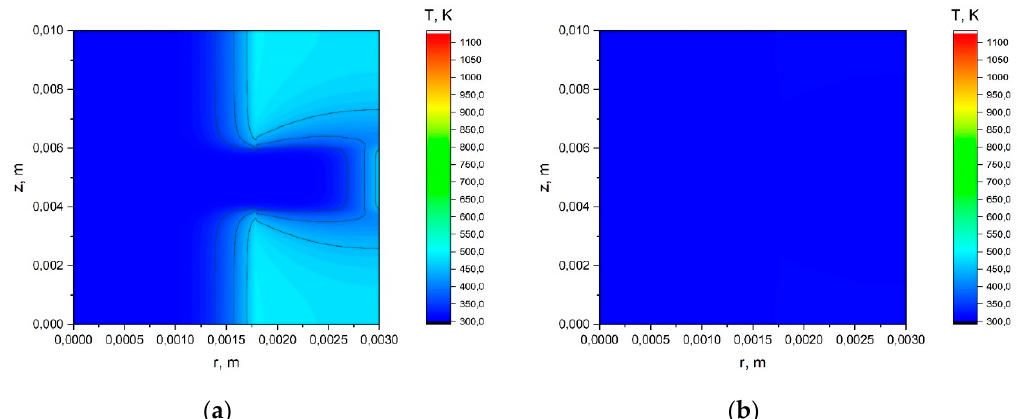
Figure A25. Temperature distribution in the stem of a herbaceous plant: R = 0.003 m, t = 0.5 s, q = 30 kW/m 2 ( a ); R = 0.003 m, t = 3 s, q = 0.5 kW/m 2 ( b ).